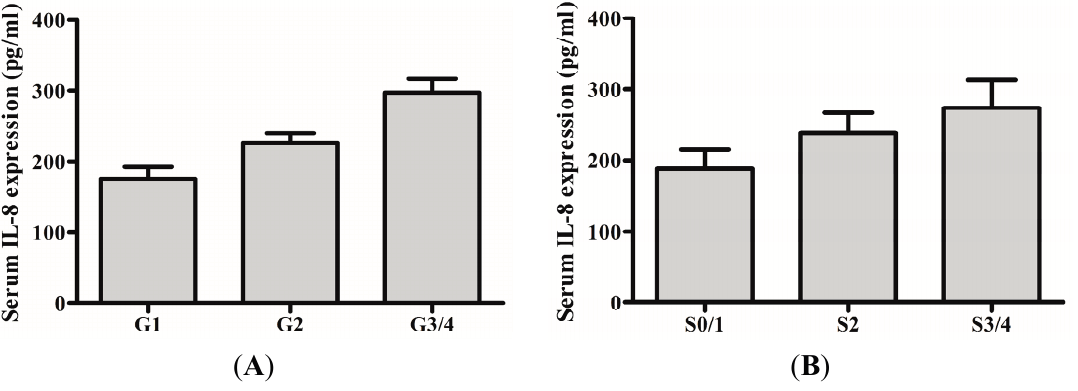
Figure 1. Serum expression of IL-8 in chronic hepatitis B (CHB) with different hepatic inflammation stages or fibrosis grades. ( A ) Detection of IL-8 protein in serum of patients with different hepatic inflammation stages by enzyme linked immunosorbent assay (ELISA); ( B ) Detection of IL-8 protein using ELISA in serum of patients with different grades of hepatic fibrosis.